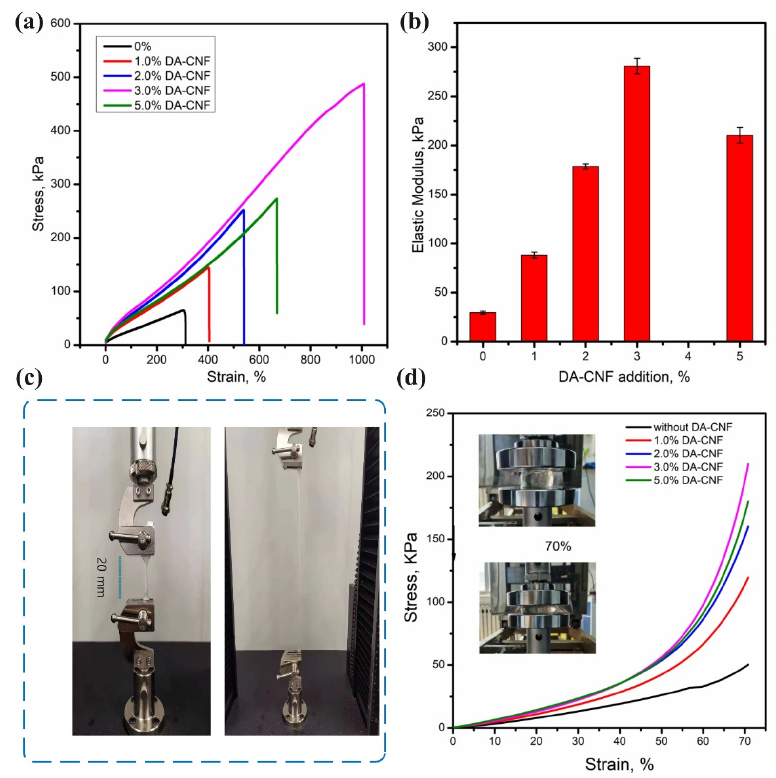
Figure 3. ( a )Tensile curves of hydrogel with different DA-CNF content. ( b ) Elastic modulus and toughness calculated from the stress–strain curves. ( c ) Images of hydrogel showing excellent mechanical properties. ( d ) Compression properties of hydrogel.